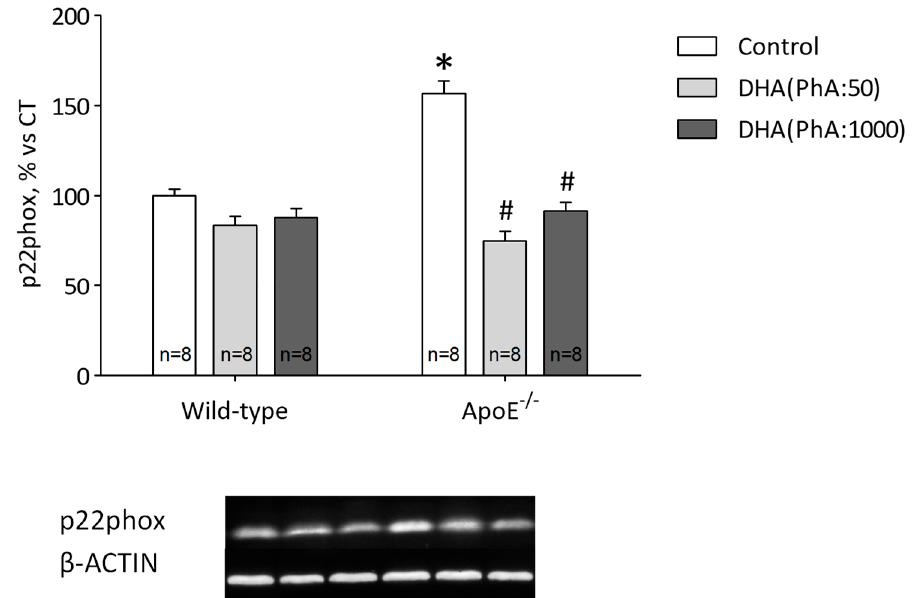
Figure 7. Effects of DHA (PhA:50) and DHA (PhA:1000) on relative protein expression of NADPH oxidase subunit p22phox (p22phox) in hippocampus of ApoE − / − and wild ‐ type mice. Data shown as mean ± SEM. * p < 0.05 compared to control wild ‐ type mice; # p < 0.05 compared to control ApoE − / − mice; $ p < 0.05 compared between DHA (PhA:50) and DHA (PhA:1000) in ApoE − / − mice. ( n = 8).